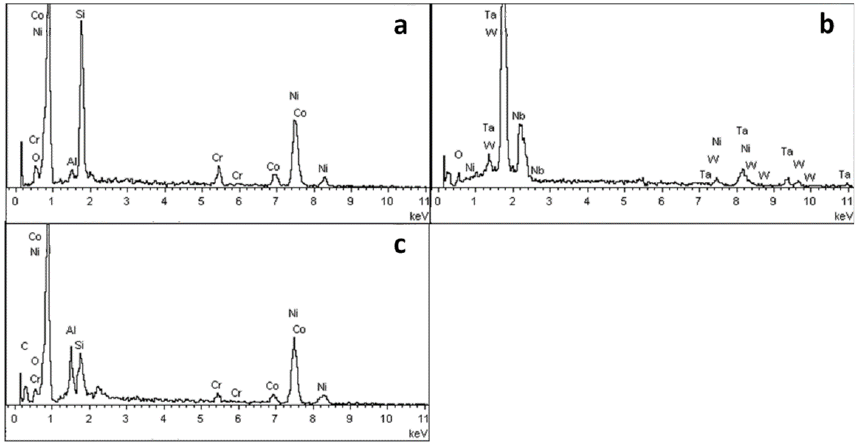
Figure 8. The EDS spectra: ( a ) point A in Figure 7b, ( b ) point B in Figure 7c, ( c ) point C in Figure 7c.